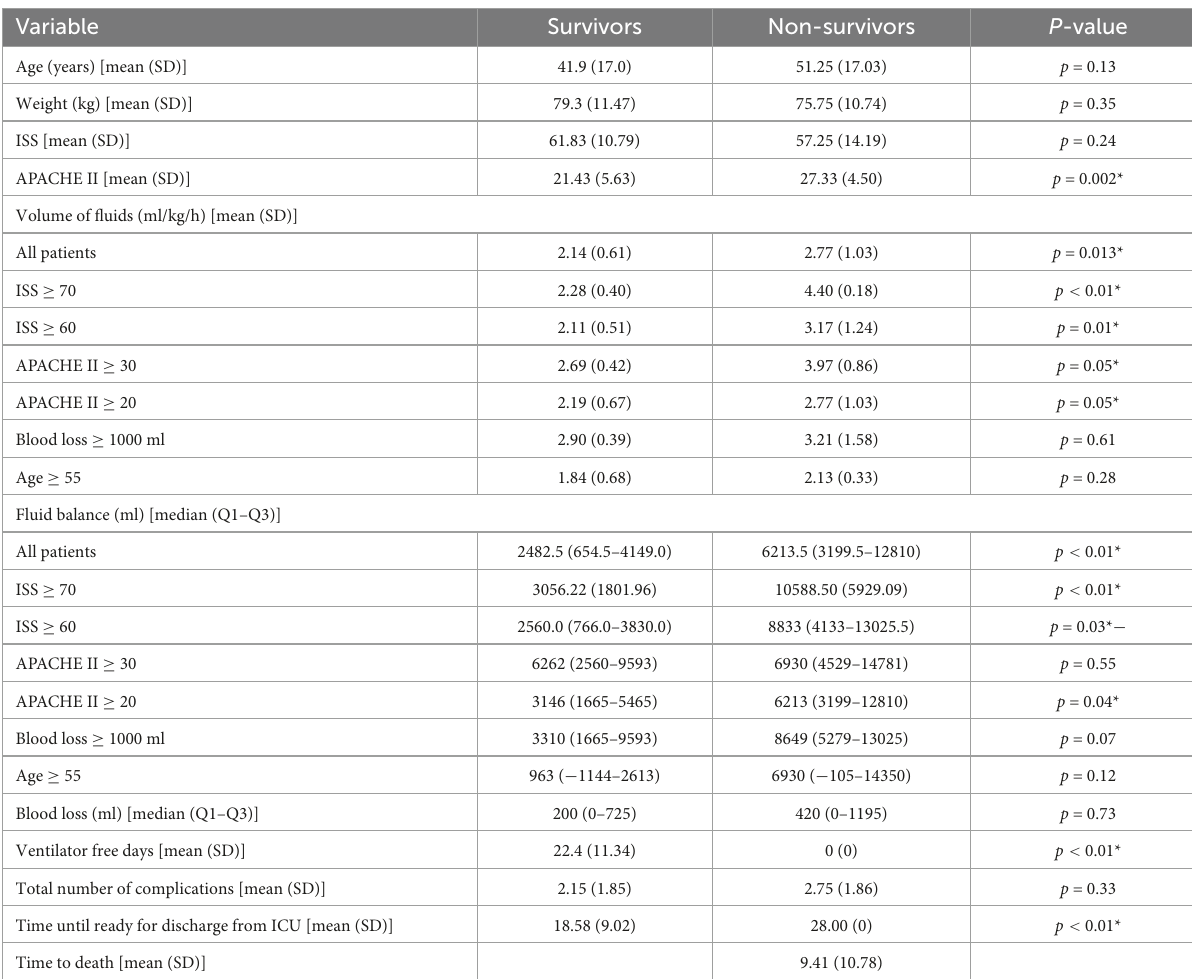
TABLE 4 Comparison between survivors and